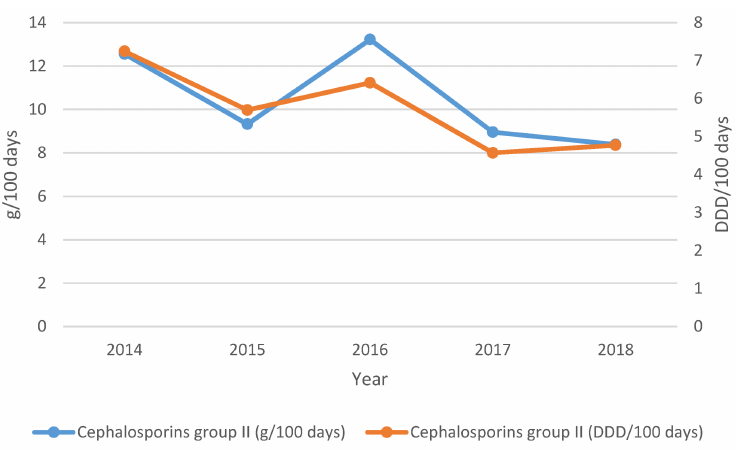
Figure 4: Cephalosporins group II, general